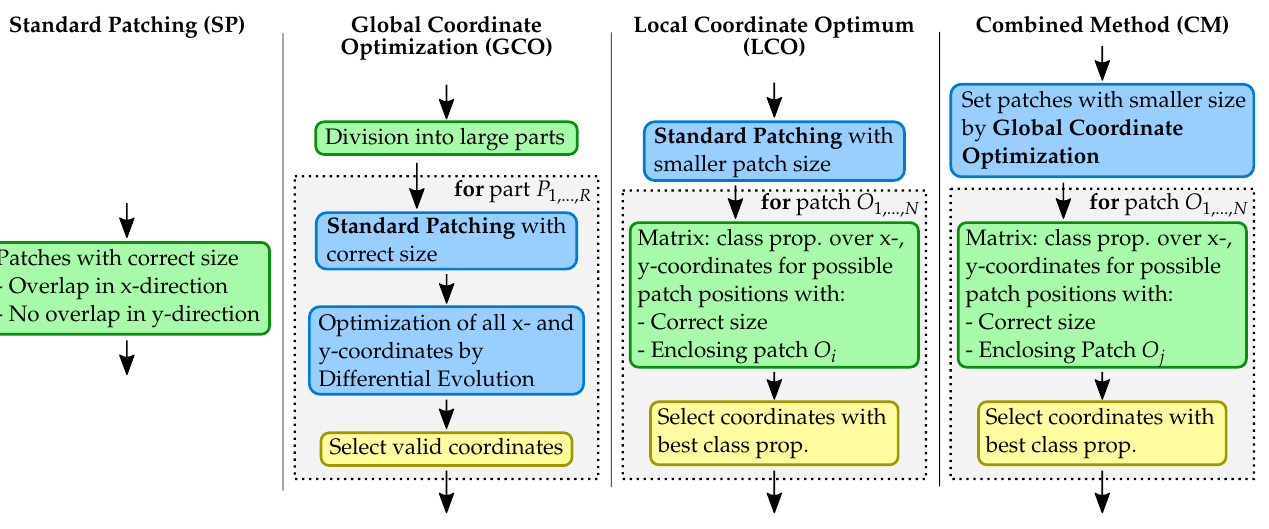
Figure 4. Visualization of the different patching methods applied in the full pipeline (see Figure 3). The input is defined as the respective overview image and a first binary segmentation (not necessary for the first method). All methods return the entire patch coordinates. In green, the algorithm steps are depicted; the blue boxes represent common or previously defined algorithms; the yellow boxes are filters or decision-making blocks based on initially defined cost functions, thresholds or